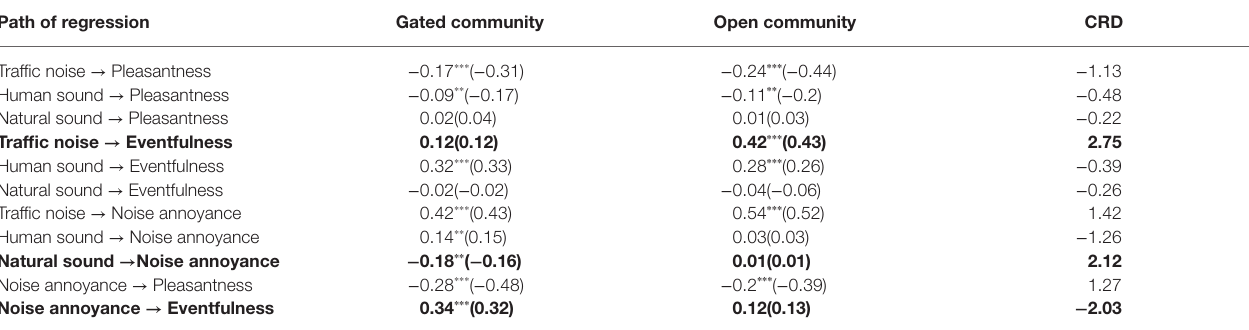
TABLE 5 | Path coefficients for the relationships among the soundscape perception parameters and comparison between the gated and open